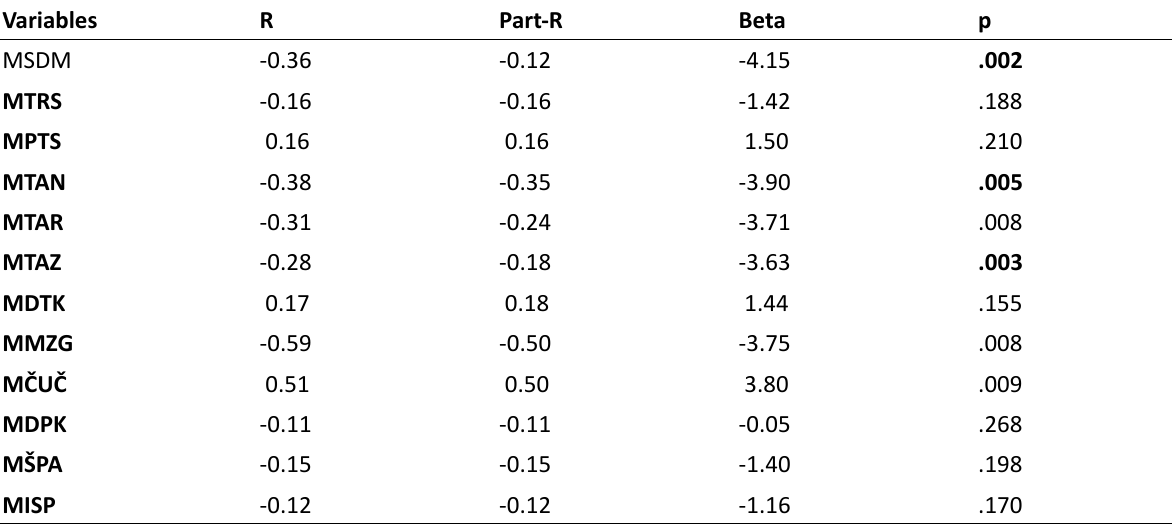
Table 4. Statistical significance parameters for the assessment of 100 sprints